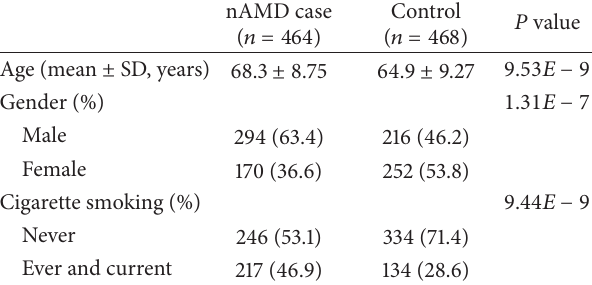
Table 2: Demographic characteristics of the